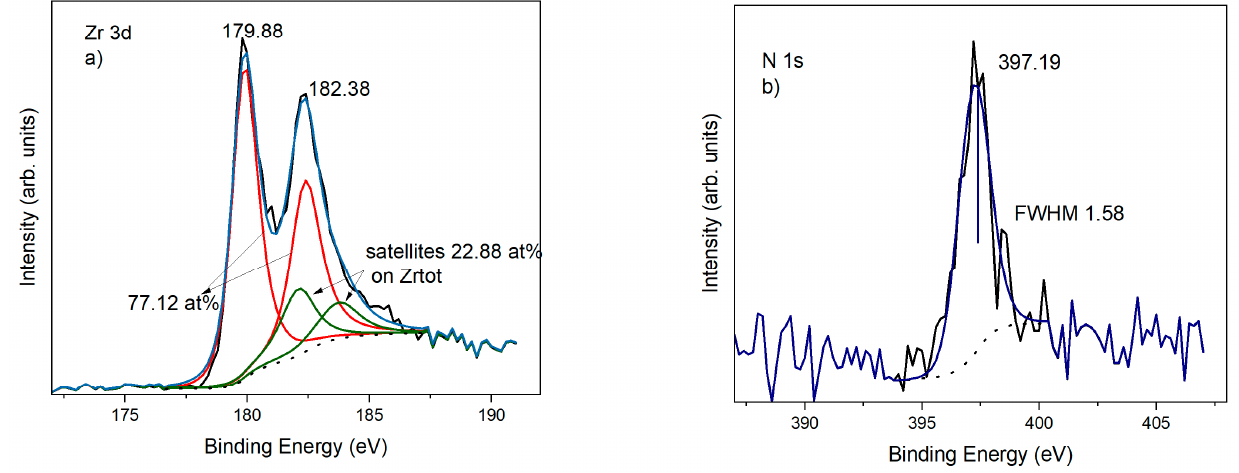
Figure 10. Comparison of N 1s (left) and Zr 3d (right) XPS regions, for the under-surface region (level 2), for the three different stoichiometric ZrN coatings: ZrN L, ZrN M and ZrN N. The formation of ZrN was associated also with sample ZrN H, whose fits of Zr 3d and N1s are reported in Figure 11a,b, respectively. The main output parameters after fit (i.e., Zr 3d peak positions, main doublet distance ∆ = 2.5 eV, N1s peak position centered at 397.40 eV) confirmed, also for sample ZrN H, the formation of the ZrN compound.